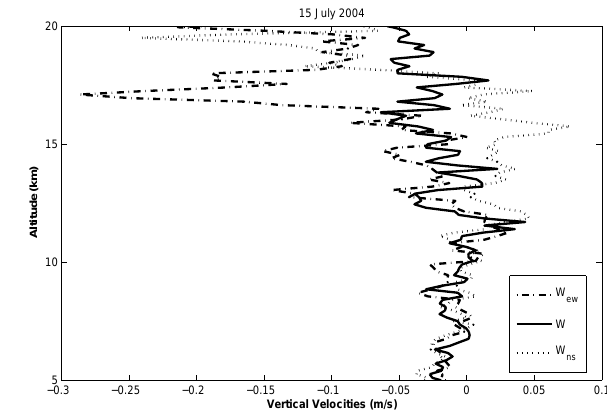
Fig. 5. Average profiles of measured and derived vertical veloci- ties using E-W ( W ew ) and N-S ( W ns ) radial beams. Error bars are plotted on mean measured vertical velocity.